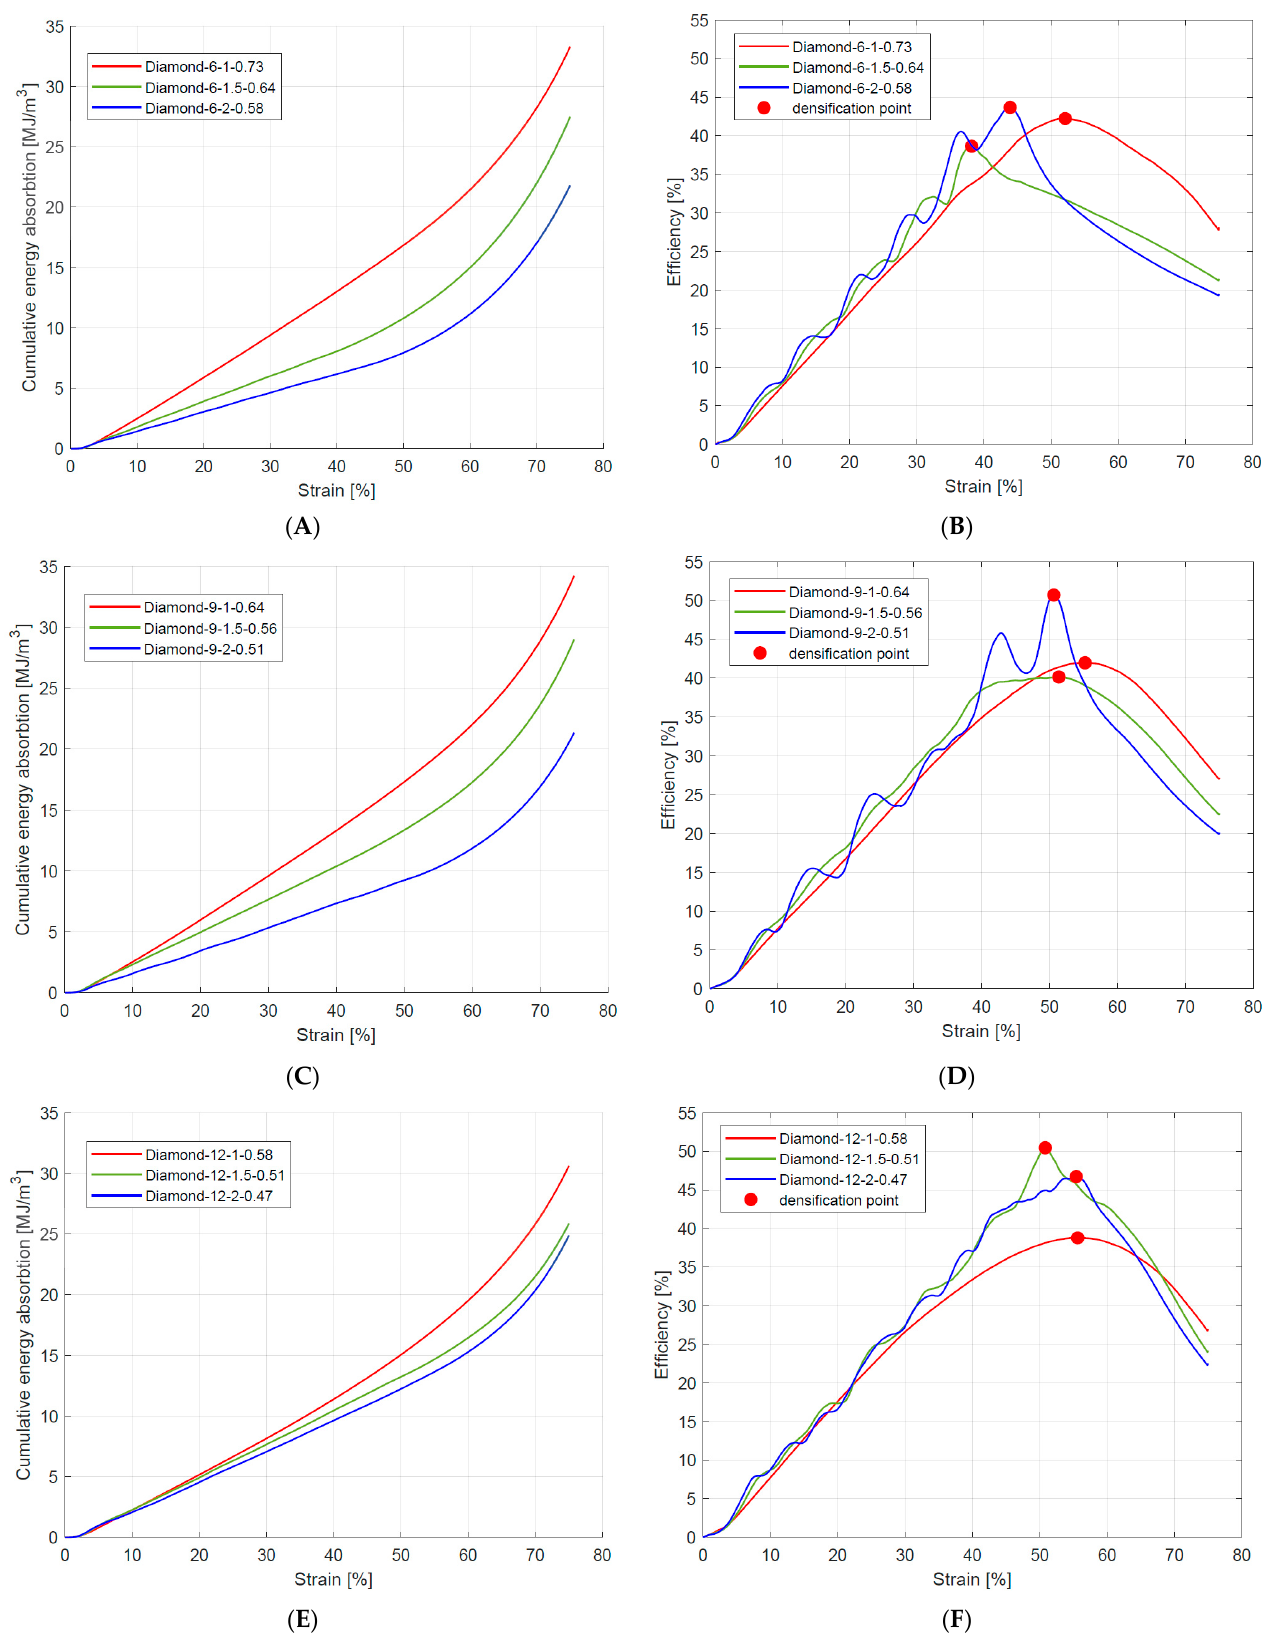
Figure 12. Energy absorption ( A , C , E ) and energy absorption efficiency ( B , D , F ) curve of tested Diamond TPMS cylindrical